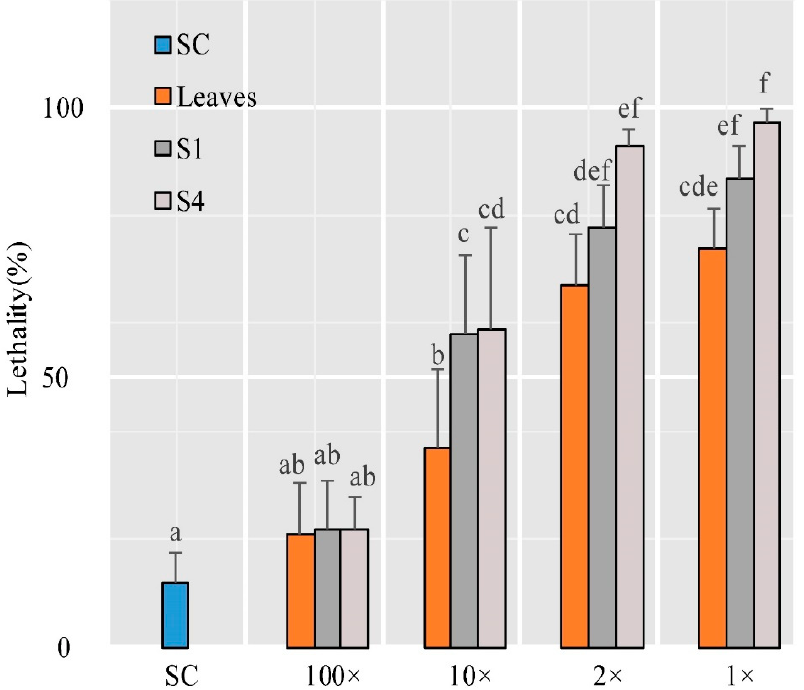
Figure 8. Insecticidal effect analysis of leaves and flowers in S1 and S4 stages. The ordinate represents the aphid lethality, and the abscissa represents the leaf disks treated with various concentrations of extract. The samples shown were diluted with 5% alcohol. 1 × : undiluted; 2 × : 2-fold dilution; 10 × : 10-fold dilution; 100 × : 100-fold dilution. Leaf disks treated with 5% alcohol were used as the solvent control. Error bars represent the standard deviations of the mean values of five replicates, and statistical analysis was performed by a one-way ANOVA test, followed by a post hoc Tukey test. The same letters indicate no significant difference; different letters (a–f) indicate significant differences ( p -value < 0.05).